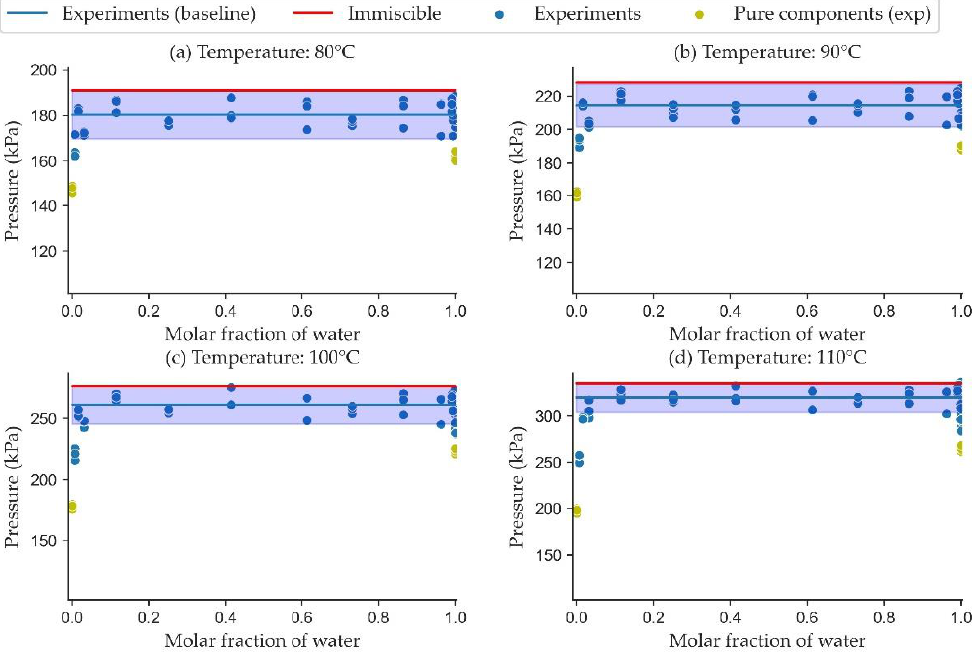
Figure 10. Experimental P mix Results at 80 ◦ C and 100 ◦ C. Note: (i) The red line describes the two-phase fully immiscible model, (ii) all P mix experimental and model derived points include the presence of air.